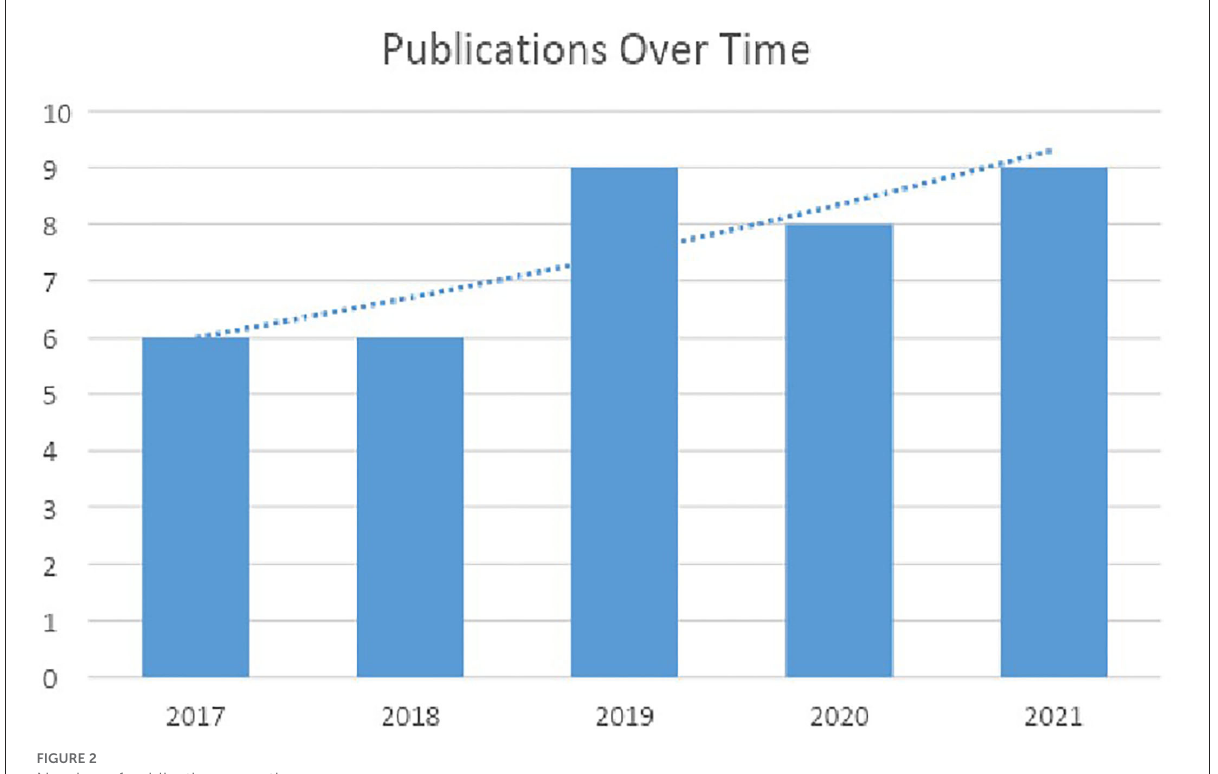
FIGURE2 Number of publications over